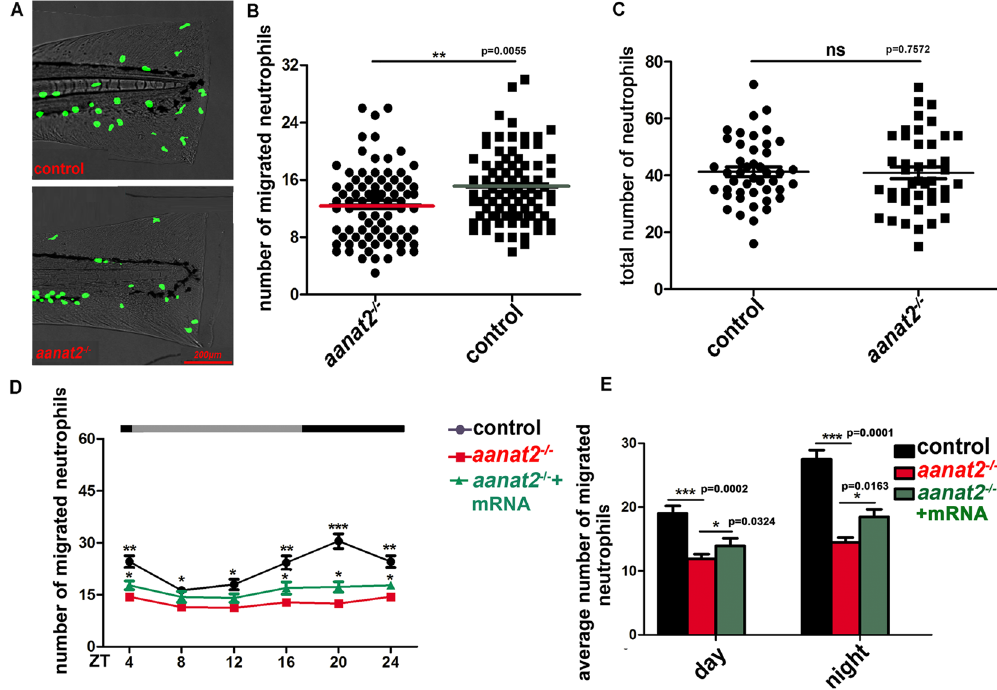
Figure 3. Neutrophil recruitment was significantly reduced in aanat2 − / − larvae. ( A , B ) Using a tail fin injury model in Tg ( lyz:EGFP ) ;aanat2 − / − zebrafish (4 days), we evaluated the effects of an aanat2 mutant on neutrophil migration at 12:00 in the day. Results showed that aanat2 mutants had significantly decreased neutrophil recruitment (control, n = 90; mutant, n = 90). Neutrophils located at 250 μ m from the wound ending were counted and regarded as the valid migration number. The experiment was repeated three times (unpaired t - test analysis). ( C ) The total number of circulating neutrophils was analyzed by counting fluorescent particles within the 800- μ m region from the spinal cord end to the anterior at 12:00. There had no significant difference between the WT/AB (n = 60) and aanat2 mutant groups (n = 60). The experiment was repeated three times (unpaired t -test analysis). Each experiment contains 60 samples. ( D ) To evaluate the rhythmic migration of neutrophils in aanat2 − / − zebrafish under LD condition, we monitored neutrophil migration at 4-h intervals in a day-night period using a fluorescent microscope. The results showed that rhythmic recruitment of neutrophils was abolished in aanat2 − / − larvae and the migrating neutrophils could be partly rescued by injection of aanat2 capped mRNA (control, n = 30; mutant, n = 30; mutant + mRNA, n = 30). The data was repeated with three independent experiments (ANOVA analysis). Each experiment contains 30 samples. ( E ) The average number of migrating neutrophils at both day and night was lower in aanat2 − / − compared with wild types (control, n = 90; mutant, n = 90). The data was analyzed from Fig. 3D. ZT: zeitgeber times. ( ** P < 0.01, *** P <